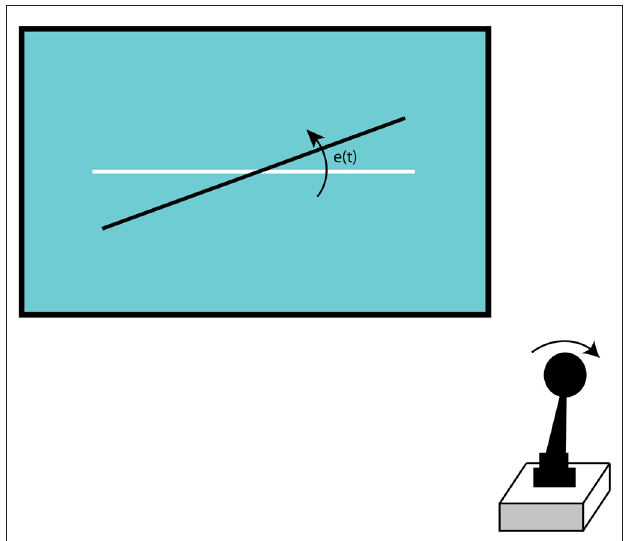
FIGURE 1 | The steering task required the participants to counteract the quasi-random displacement e(t) of the rotating line (black) to the non-moving reference line (white), with lateral sidestick